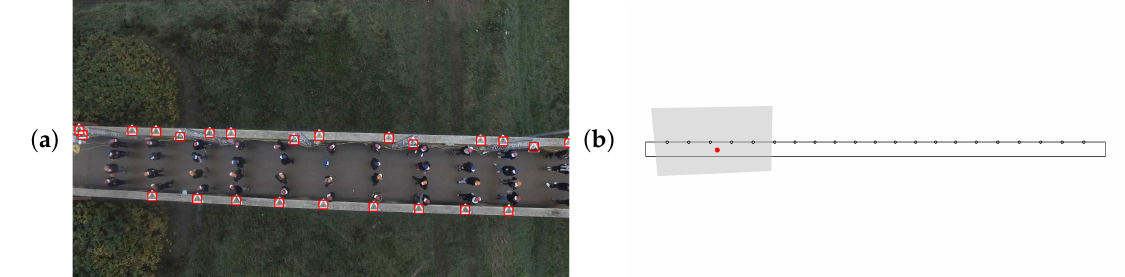
Figure 13. Calibration of the static camera setup: ( a ) calibration frame of static camera 3 with indication of image correspondence points ( ) and the reprojected world correspondence points (cid:52) ( (cid:3) ) and ( b ) average reprojection error of the 21 calibrated static cameras.